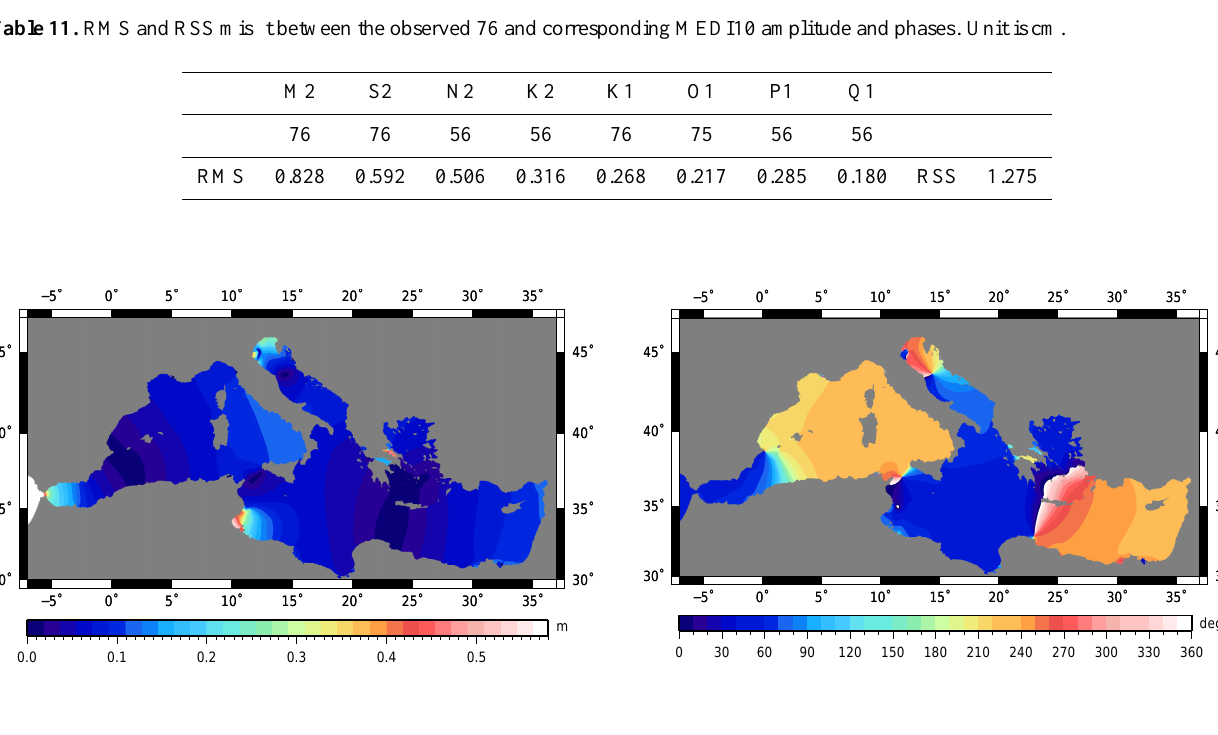
Fig.5. PhaseoftheM2constituent(degreesrelativetoUTC) Fig. 5. Phase of the M2 constituent (degrees relative to